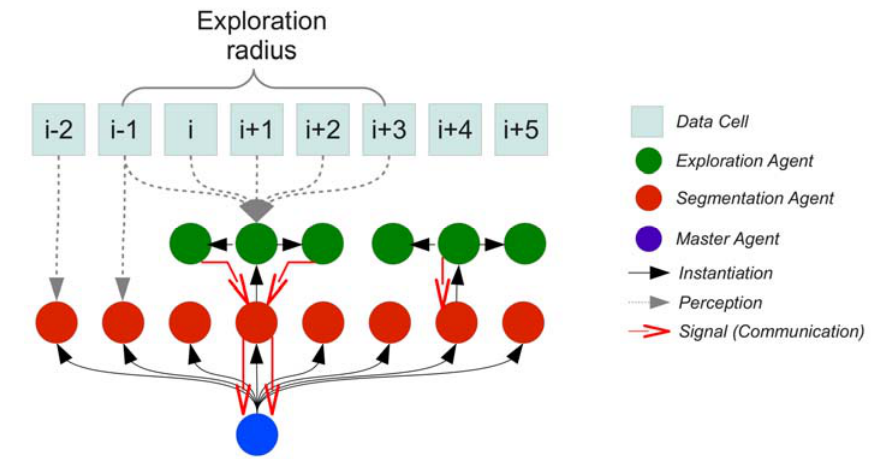
Figure 2. The MAS: Perception; Event ‐ based instantiation of explorer agents; Diffusion and Reproduction; Communication via